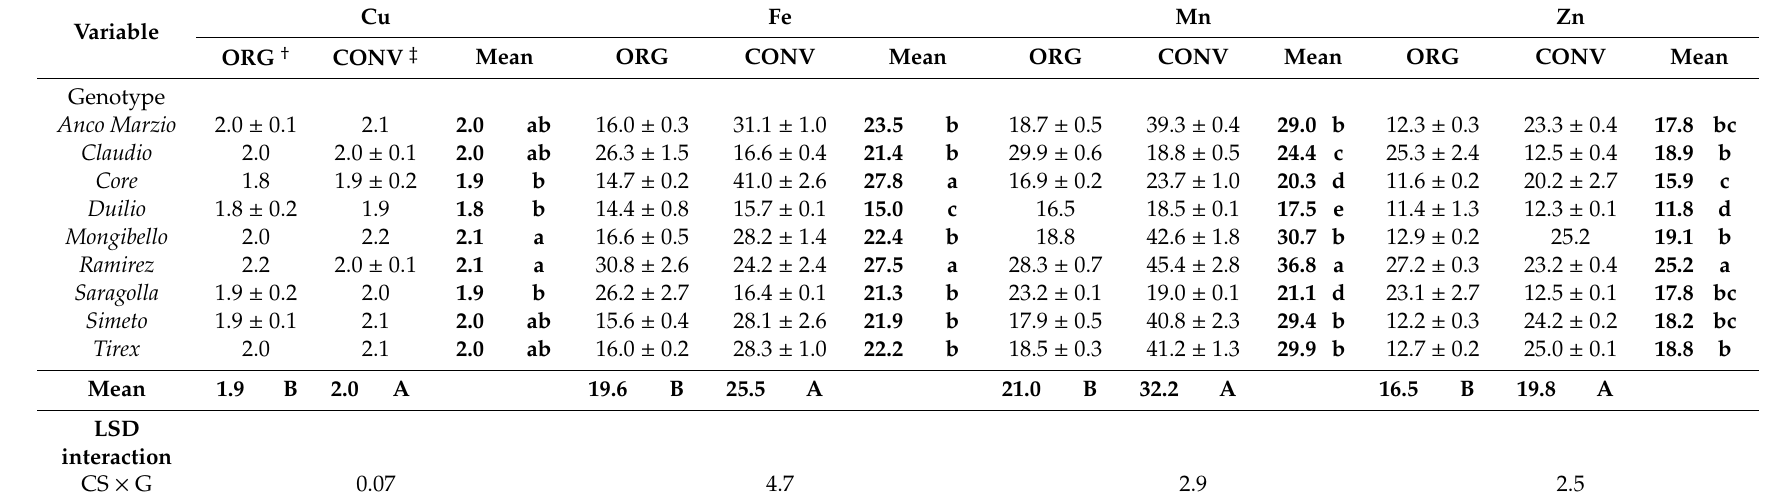
Table 7. Micro-minerals content (mg kg − 1 of fresh weight) as a ff ected by ‘cropping system (CS) × genotype (G)’ interaction. Di ff erent letters (a–e or A, B) within